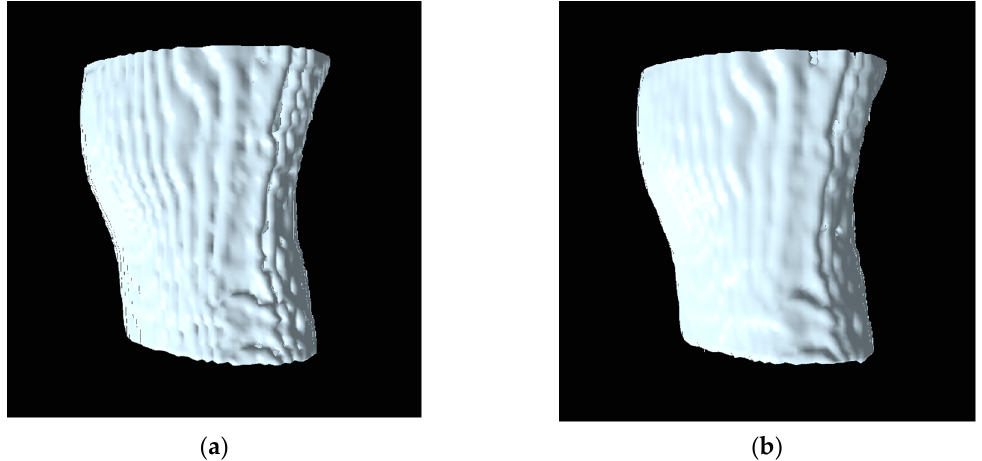
Figure 13. ( a ) The surface rendering using the traditional marching cubes [14]; ( b ) the surface rendering using the marching cubes with histogram pyramids. Table 1. The experimental